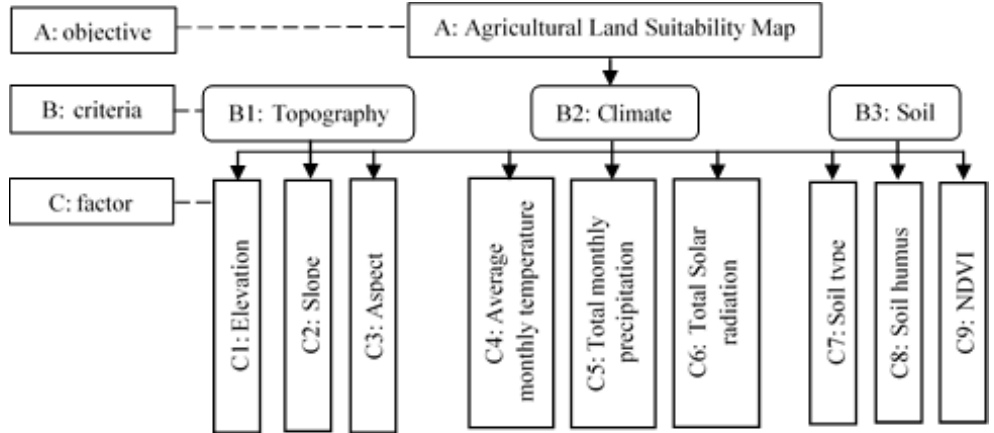
Figure 3. Criteria structure of cropland suitability evaluation factors of central